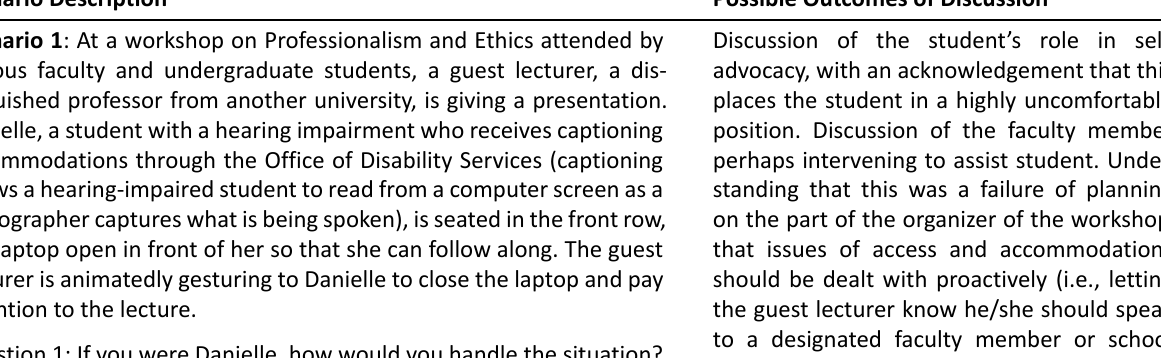
Table 1, “Examples of Scenarios”, is presented below: